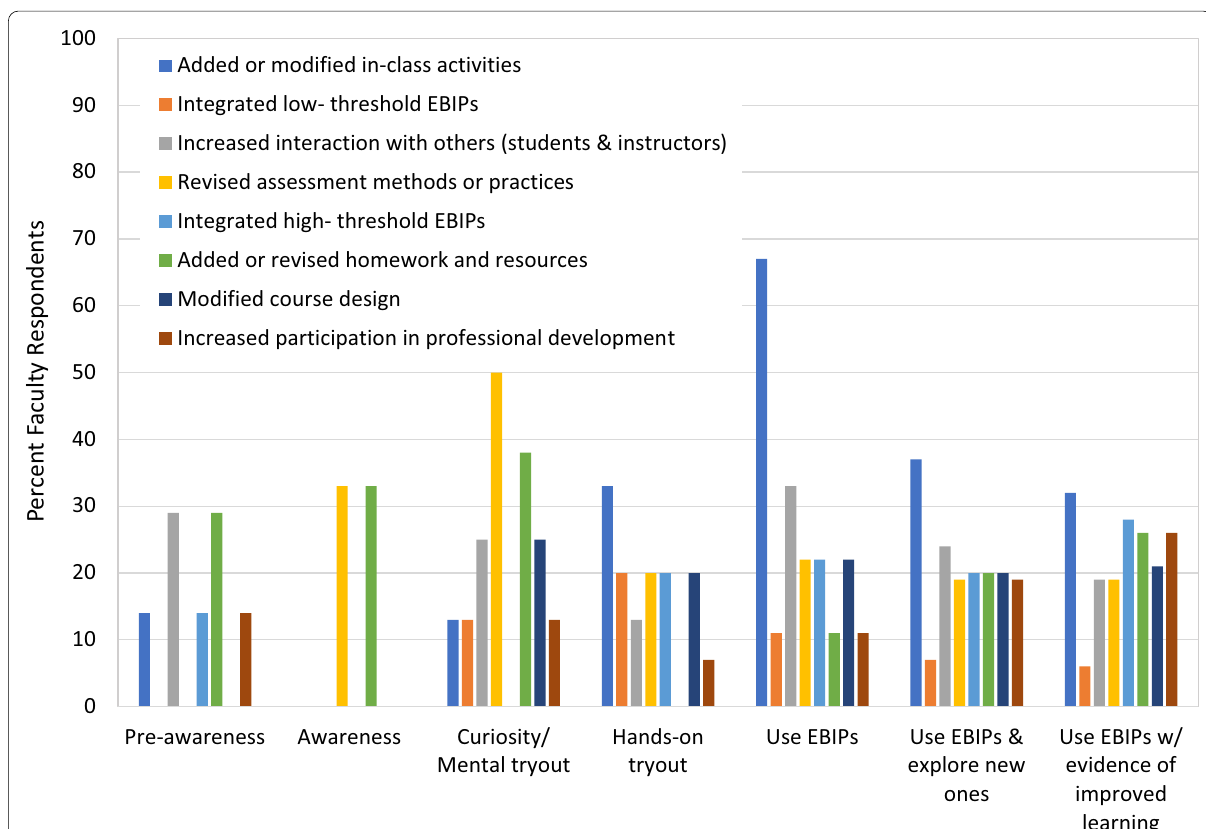
Fig. 5 Changes to teaching practices reported by faculty respondents at different EBIP adoption stages